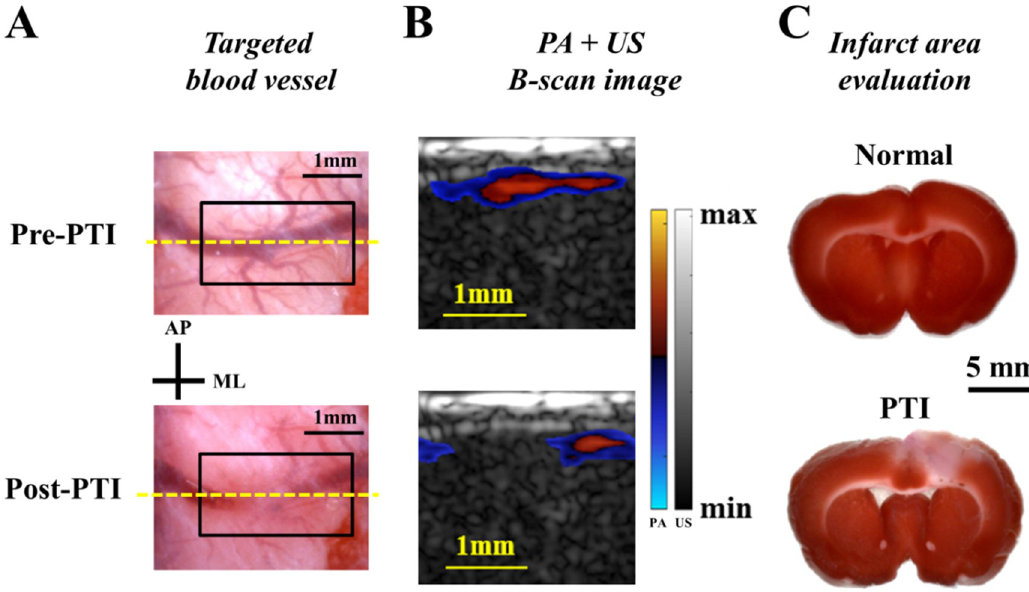
Figure 7. Performance evaluation of the photoacoustic (PA) imaging system based on the PTI model. ( A ) The photos of the selected cortical blood vessel pre- and post-PTI within the cranial window. The yellow dashed line indicates the location of the PA B-scan image, while the black rectangle is the ischemic region. ( B ) Co-registered PA-US B-scan images. The cerebral blood volume (CBV) of the selected cerebral blood vessel shown in the post-PTI image was substantially lower than that shown in the pre-PTI image. ( C ) TTC staining results with and without PTI are presented to support the results of the in vivo PA